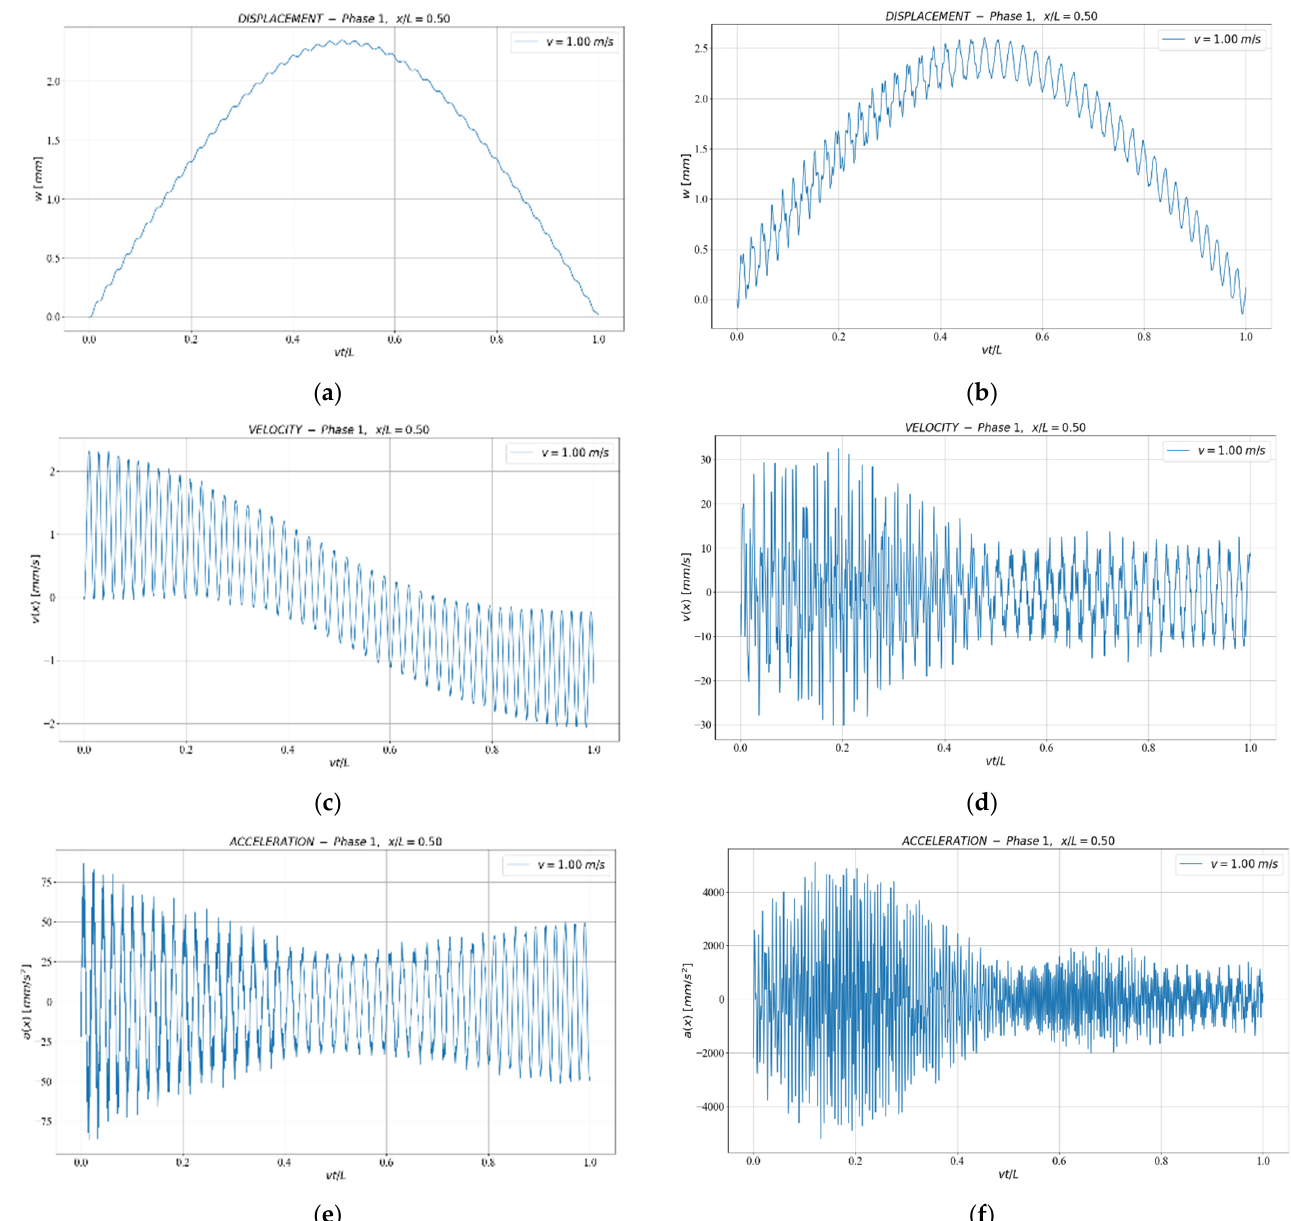
Figure 4. Moving point mass across the model steel girder with simple supports: left column ( a , c , e ) plots the displacement, velocity and acceleration at station x=L/2 for rigid supports; right column ( b , d , f ) plots the displacement, velocity and acceleration at station x=L/2 for elastic supports.